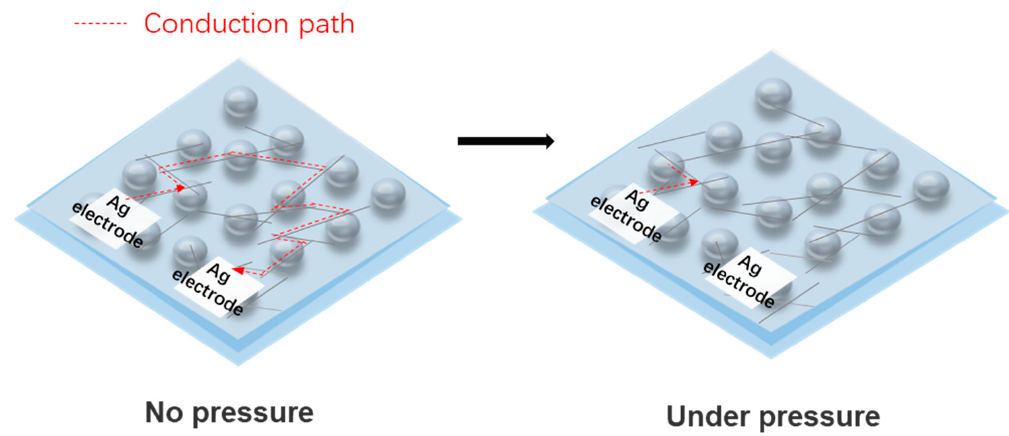
Figure 12. Schematic diagram of the distribution of a low-density AgNWs network on PDMS-expandable microsphere structure with and without applied pressure.